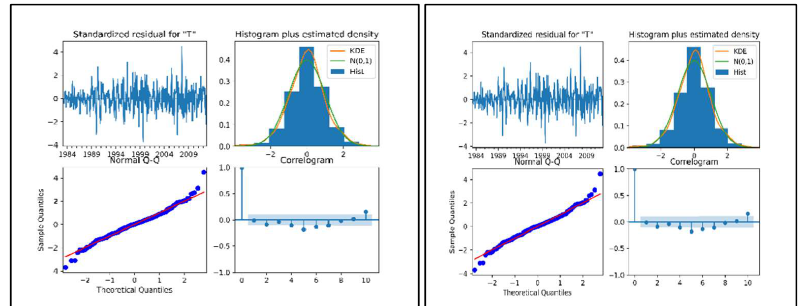
Figure 5. Diagnostic checking of the standardized residuals, histogram, normal Q-Q, and correlo- gram plots of the SARIMAX (right side) and SARIMA (left side) model for natural gas production.